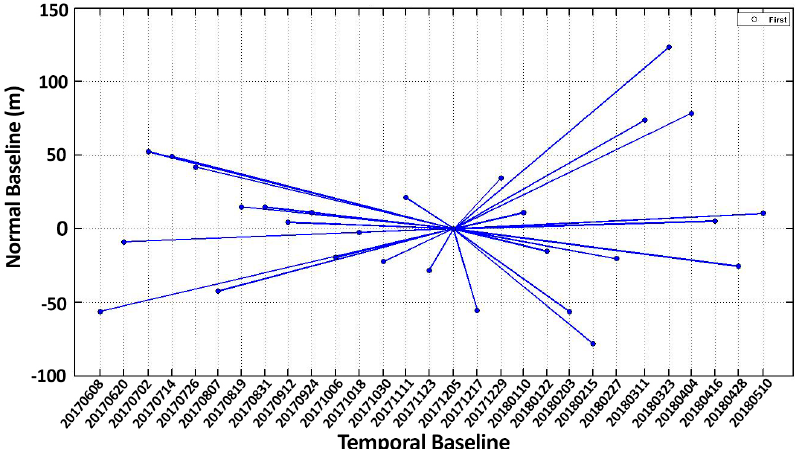
Figure 2. The spatiotemporal baseline configuration of interferometric pairs showing the SLC data in this study (29 images): Sentinel-1A, descending mode (track 71), and polarization